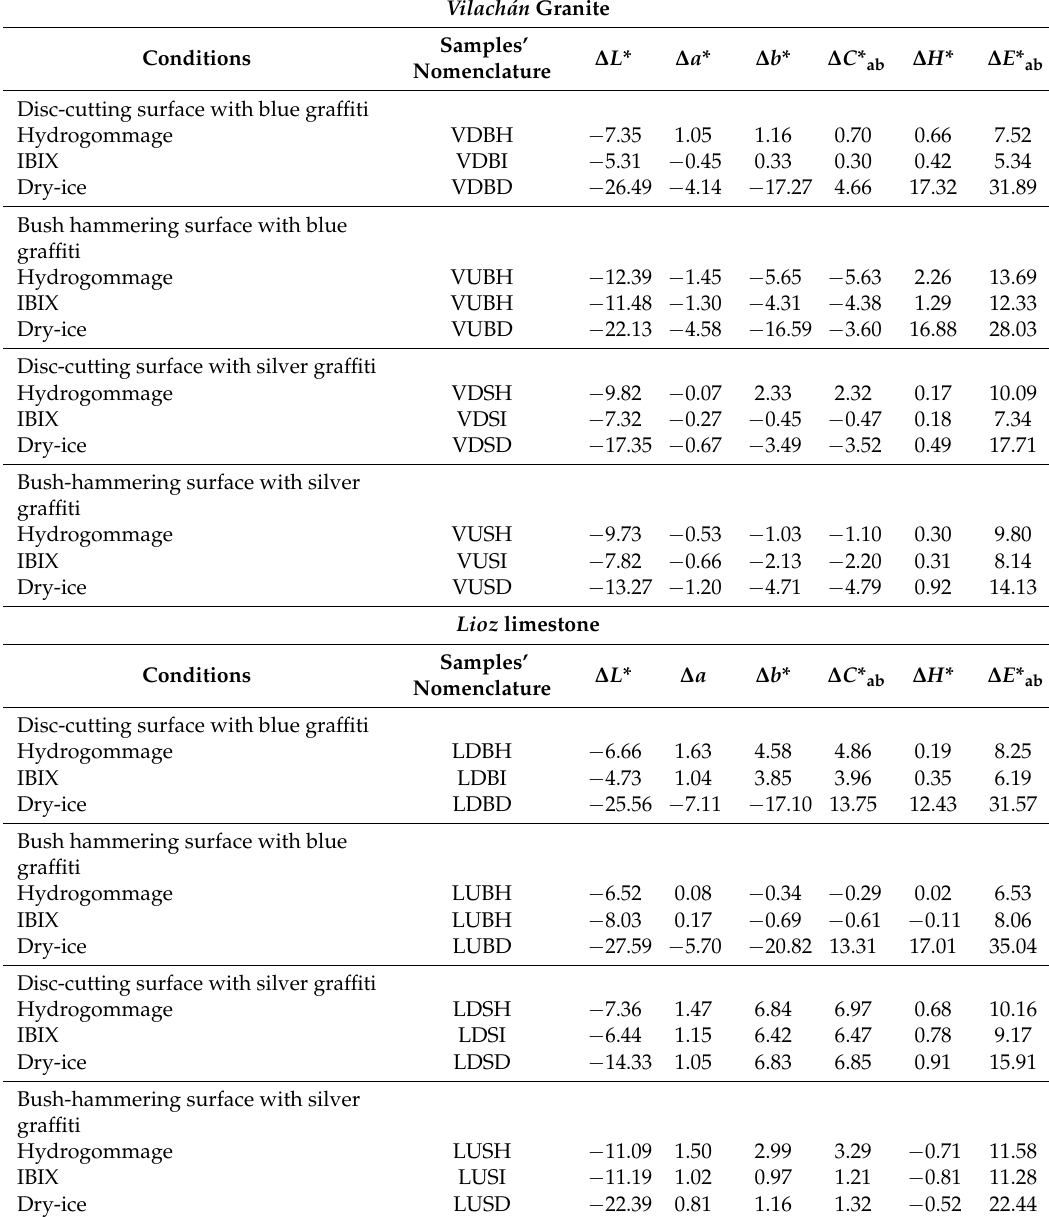
Table 2. Colorimetric differences ( ∆ L *, ∆ a *, ∆ b *, ∆ C * ab and ∆ H *) and global color change ( ∆ E * ab ) of the surfaces cleaned with the different procedures. Differences were computed relative to the color of the reference stone; therefore, the lower the ∆ E * ab , the more similar to the reference surface the cleaned surface. See Table 1 for samples’